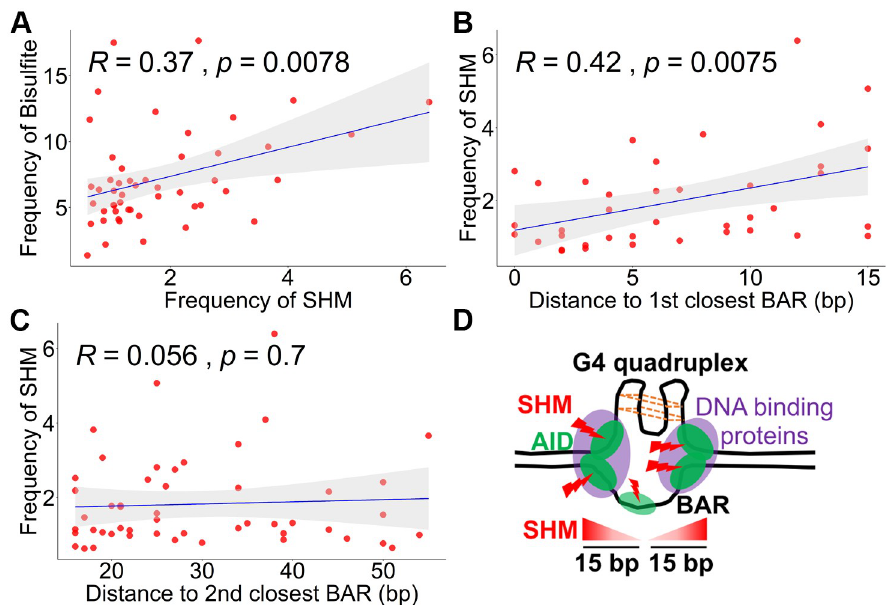
Fig 5. Spatial correlation between the highly mutated sites in SHM and the BARs. (A) the relationship between the frequency of SHM for the top 25 highly mutated sites from both strands (50 sites in total) and the corresponding frequencies of bisulfite accessibility. (B) the correlation between the same 25 highly mutated sites from both strands and their respective distance to the closest BARs with 15 bp context. (C) the correlation between the same 25 highly mutated sites from both strands and their respective distance to the second closest BARs, all of which are beyond 15 bp. The frequency of Bisulfite and frequency of SHM shown in panel A-C are in the form of 10 − 3 for better visualization. (D) The potential model displaying the correlation among SHM, BARs and G4 quadruplex. The red lightning symbol shows SHM introduced by AID (green oval). The purple ovals represent protein complexes that occupy the ssDNA region to facilitate AID to mutate. The bottom triangles with gradient red color shows SHM which deeper red color represents higher mutation within 15 bp context.